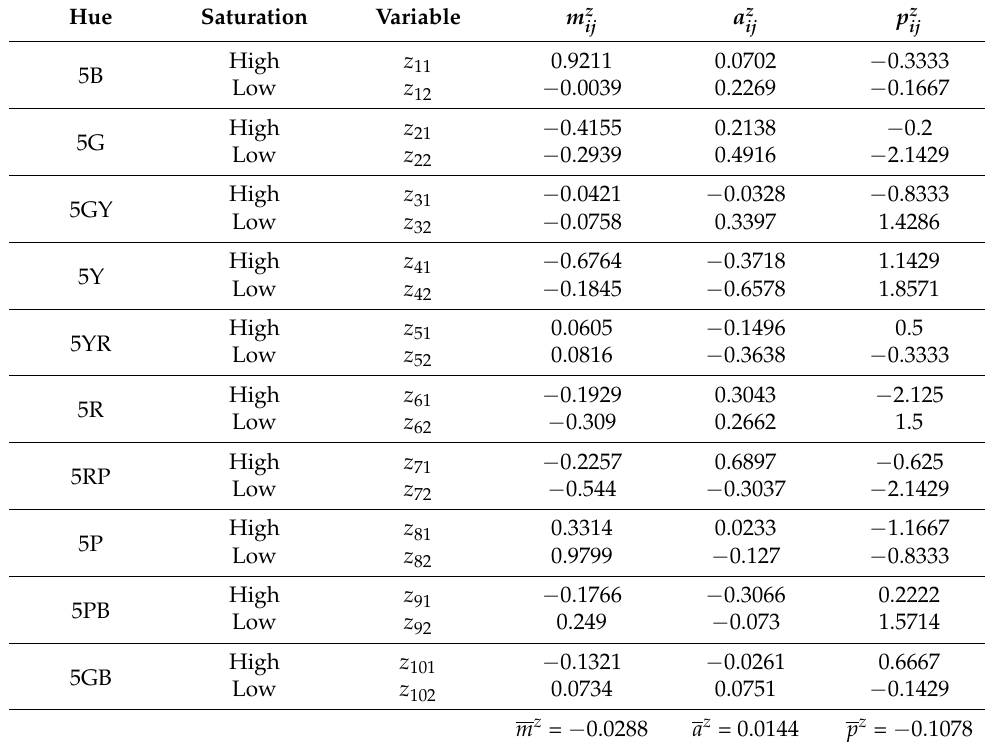
Table 4. Grouping of variables for each parameter of the classroom characteristic